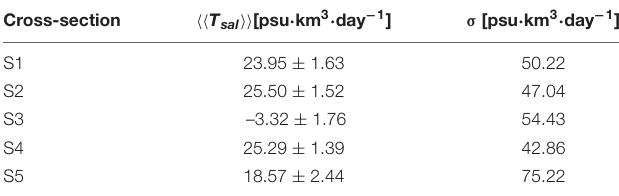
TABLE 2 | Mean value (cid:104)(cid:104) T sal (cid:105)(cid:105) and standard deviation σ of the daily salt water transport T sal through cross-sections S1–S5 calculated from the 10-year time series (2010 –2019) of T sal .